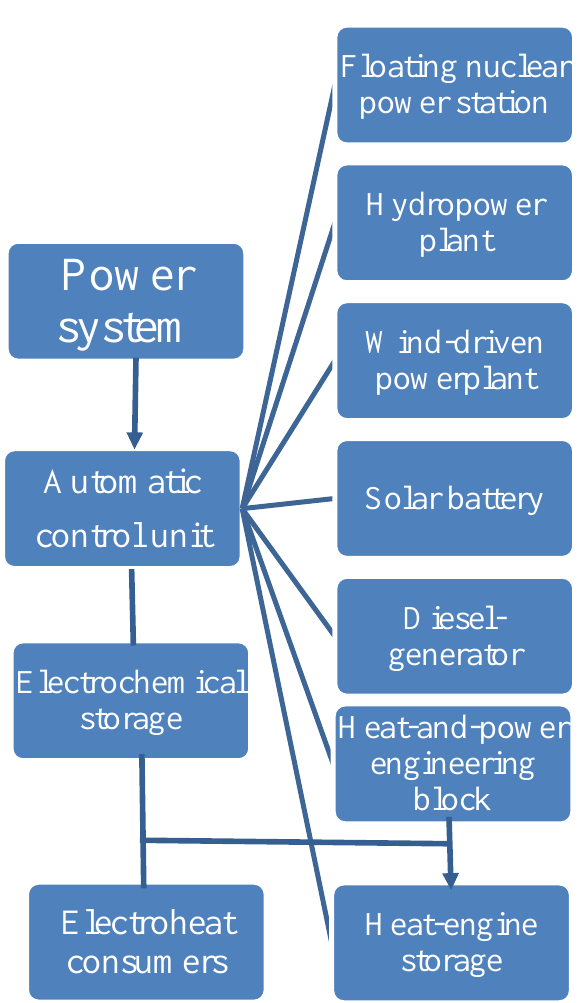
Figure 1. The combined electro heat supply of